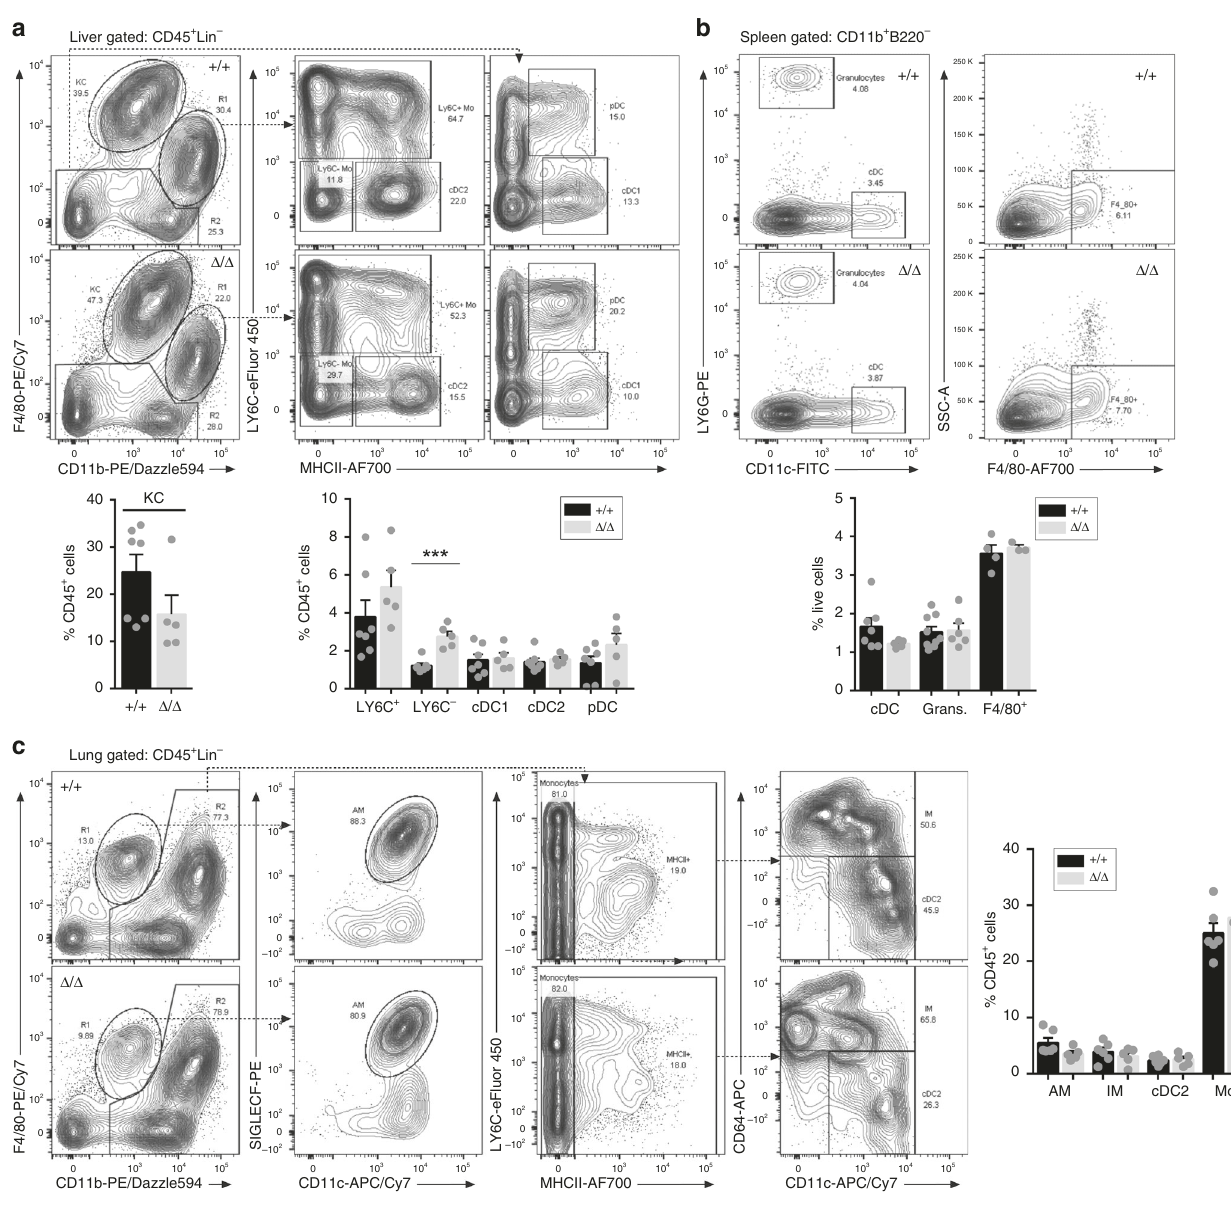
Fig. 4 Macrophage populations in liver, spleen, and lungs are unaffected in FIRE-de fi cient mice. a Leukocyte populations were analyzed from enzymatically digested livers from mice aged between 8 and 10 weeks. Flow cytometry pro fi les show representative Csf1r + / + ( + / + ) and Csf1r Δ FIRE/ Δ FIRE ( Δ / Δ ) mice using the gating strategy described by Hawley et al. 11 . Kupffer cells (KC) were identi fi ed as CD45 + , lineage − (Lin-; CD3 − CD19 − LY6G − ) and F4/ 80 hi CD11b lo (Panel 1). F4/80 lo /CD11b hi and F4/80 − /CD11b − populations were further separated on the basis of LY6C and MHCII expression (Panels 2 and 3). Mo monocyte, cDC conventional dendritic cell, pDC plasmacytoid dendritic cell. n = 7 + / + and 5 Δ / Δ from 3 repeat experiments. P = 0.0002 (***). b Leukocyte populations were analyzed from enzymatically digested spleens from mice aged between 8 and 10 weeks. The fl ow cytometry pro fi les show representative Csf1r + / + ( + / + ) and Csf1r Δ FIRE/ Δ FIRE ( Δ / Δ ) mice. Conventional dendritic cells (cDC) were identi fi ed as CD11b + B220 − CD11c + LY6G − and granulocytes as CD11b + B220 − CD11c − LY6G + (Panel 1). Red pulp macrophages were identi fi ed as CD11b + B220 − F4/80 + SSC lo (Panel 2). n = 3 – 9 mice per genotype from 4 repeat experiments. c Single cell suspensions of digested lungs were analyzed by fl ow cytometry as described above for the liver using the same cohort of mice. Alveolar macrophages (AM) were de fi ned as F480 + CD11b lo (Panel 1) and CD11c + SIGLECF + (Panel 2). The CD11b + F4/80 − / + cells were further analyzed to de fi ne the monocytes (Mo, MHCII − LY6C − / + , Panel 3), interstitial macrophages (IM, MHCII + CD11c − / + CD64 + ) and conventional dendritic cells subset 2 (cDC2, MHCII + CD11c + CD64 − ) in Panel 4. All source data are provided within a Source Data excel fi le. Graphs show mean + SEM and P values were determined by two-tailed t indistinguishable from the controls (Supplementary Fig. 4e and f). However, there is a signi fi cant increase in LY6C lo monocyte-like As in the liver, there is no change in the spleen-to-body weight ratio cells (CD11b + F4/80 lo ). The full gating strategy for liver fl ow or the relative abundance of myeloid populations de fi ned by cytometry data is shown in Supplementary Fig. 4d. staining for F4/80 + or other markers (Supplementary Fig. 4g, h and The marginal zone is completely absent in the spleen of Csf1 op/op mice 28 and in Csf1r − / − rats 5 . In Csf1r Δ FIRE/ Δ FIRE mice the overall Fig. 4b). The full gating strategy for spleen fl ow cytometry data is architecture and relative area of the marginal zone is shown in Supplementary Fig. 4i.